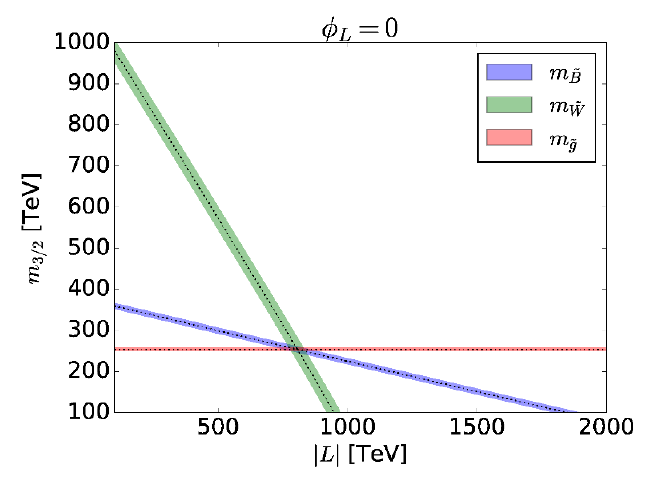
Figure 14 . Contours of constant gaugino masses on the j L j vs. m dotted lines show the true gaugino masses for Sample Point 1, while the bands show expected uncertainties due to the uncertainty in the gaugino mass determination.